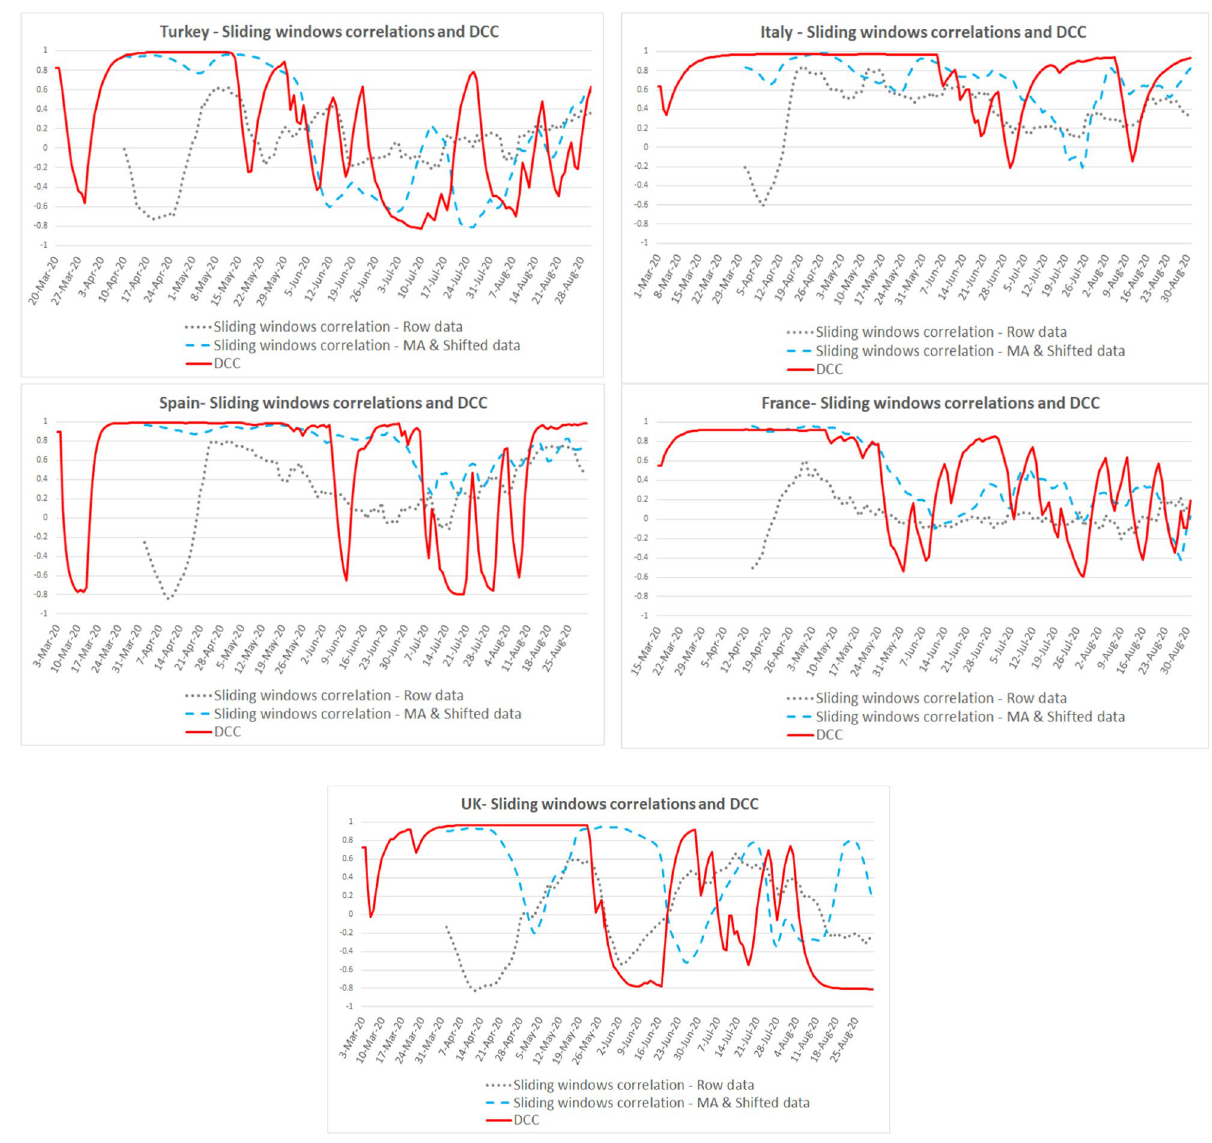
Figure 3. Correlations between fever symptom search and new